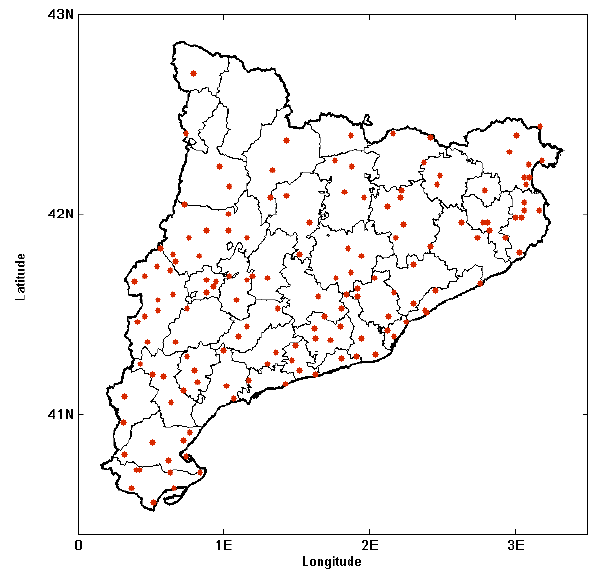
Fig. 2. Location of the 146 automatic rain gauges (red dots) from the XEMA network all over Catalonia in 2008, with the comarca division (thin black line). This represents an average density of ∼ 1 rain gauge/200 km 2 .